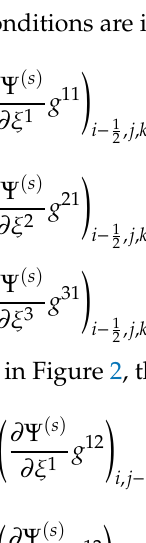
Figure 2. Cell stencil for an internal boundary defined by the cell interfaces between the calculation cells [ i − 1, j ] and [ i − 1, j + 1 ] , between the calculation cells [ i − 1, j ] and [ i , j ] , and between the calculation cells [ i − 1, j ] and [ i − 1, j − 1 ] , with k = − 1,0,1. Grey cells represent internal objects.